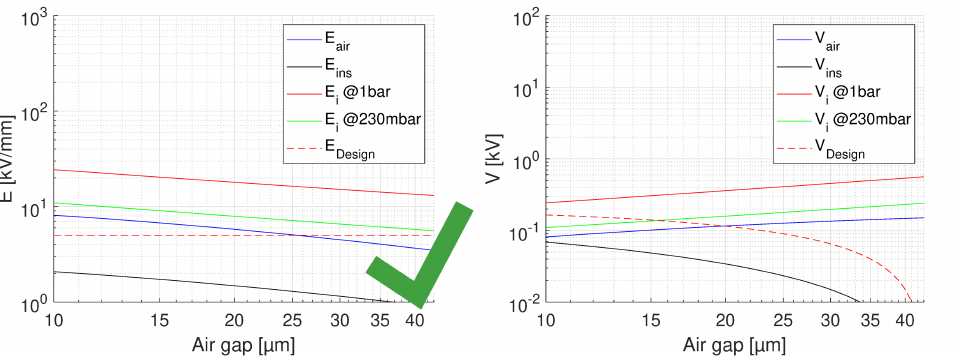
Figure 9. Feasibility plot for the optimum design of turn insulation, with the highest design field (5 kV/mm), and thinnest insulation (43 µ m). Maximum voltage drop between turns 150 V. The x axis reports the air gap thickness. Left: field, Right: voltage. No PD will be incepted in cavities of any size and in the considered pressure